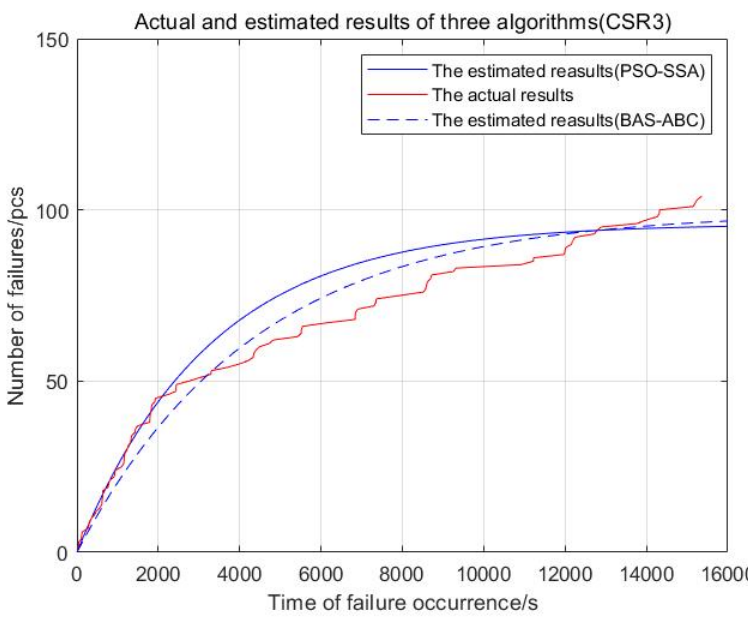
Figure 22. Actual and estimated results of two algorithms (CSR3). From Figures 18–22, the red curve represents the actual number of failures over time. The BAS-ABC estimation prediction curve analysis proposed in this paper is closer to the actual curve than the PSO-SSA algorithm, which shows that the BAS-ABC hybrid algorithm improves the accuracy of the algorithm